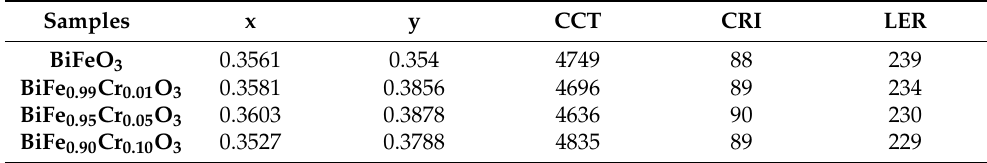
Table 2. The values of the parameters obtained by plotting the CIE 1931 chromaticity